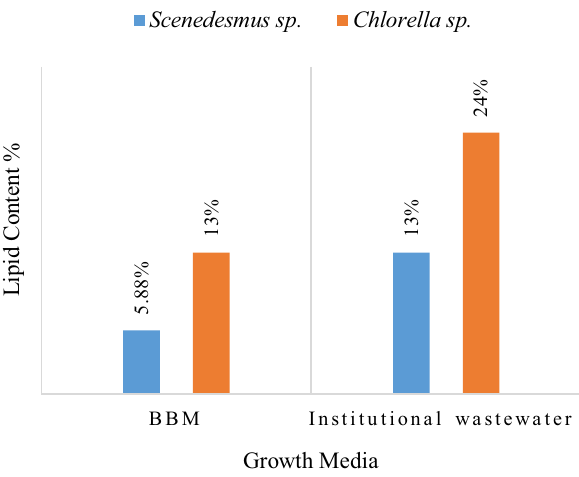
Fig. 4 Lipid content of isolated microalgae